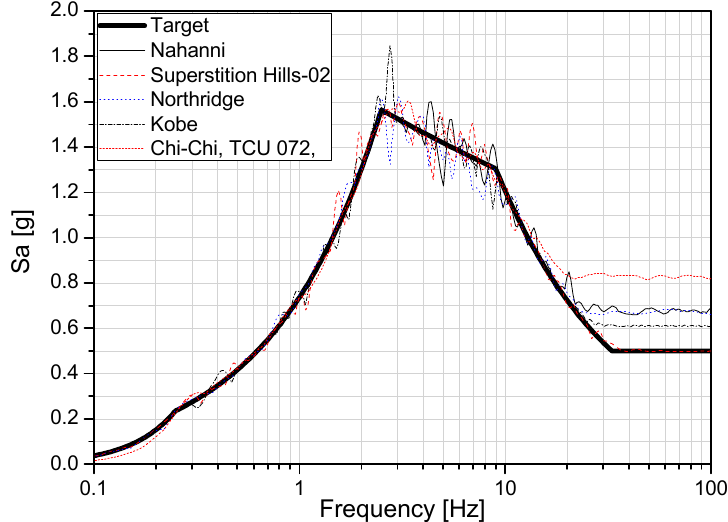
Table 4. Material properties of the piping system. Table 5. Characteristic of the seed earthquake.